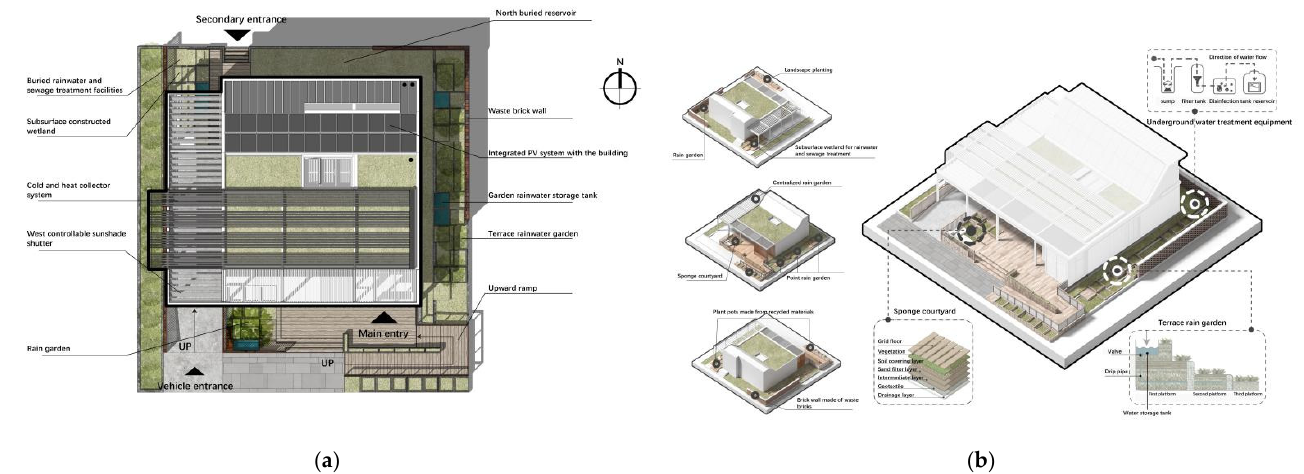
Figure 8. BIM-based site design. ( a ) Site design; ( b ) site design analysis.